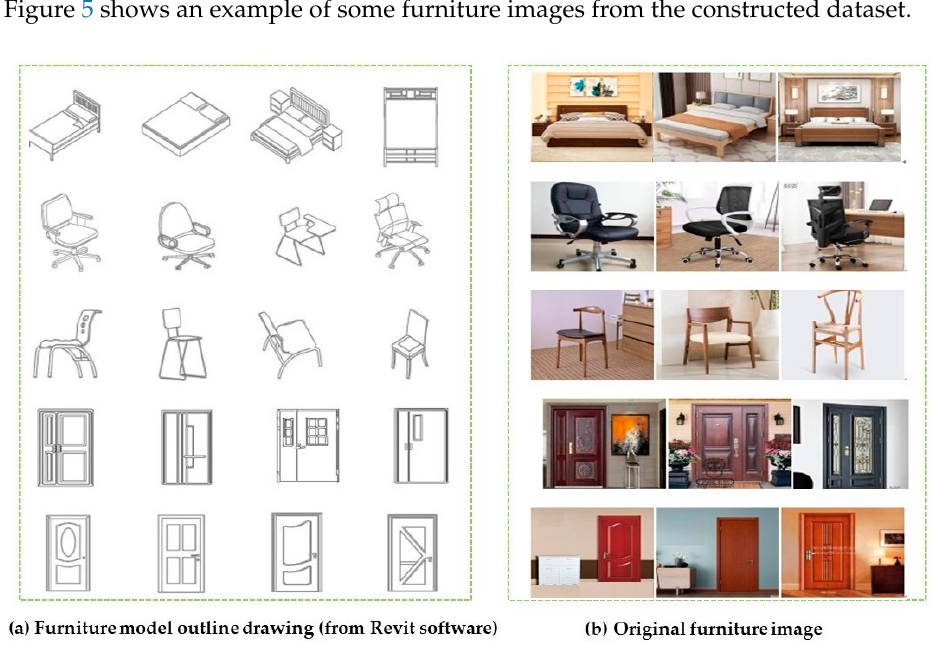
Table 2. Breakdown of the major and minor categories of the BIM family images.